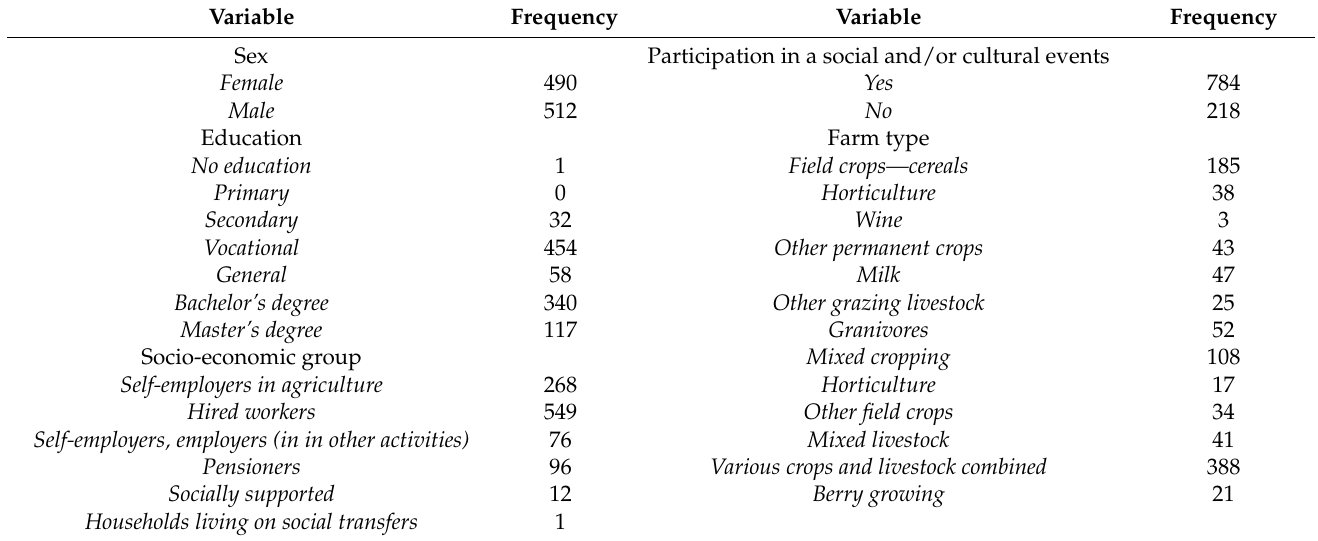
Table A2. Descriptive statistics of the main qualitative